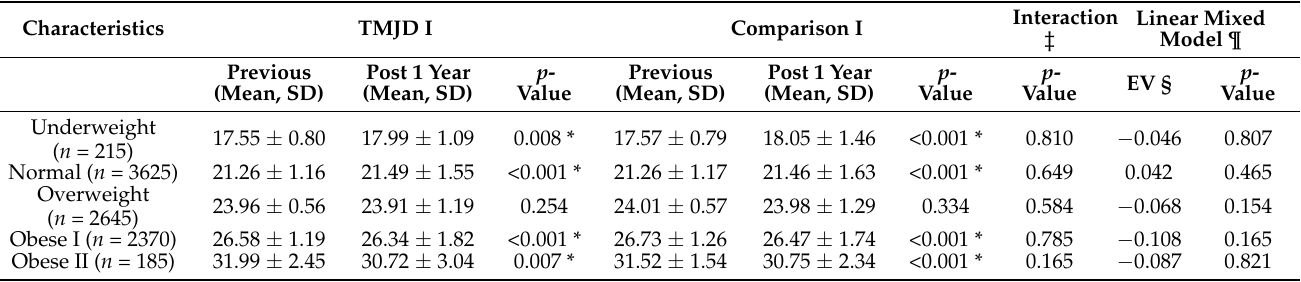
Table 3. Differences in mean BMI between pre- and 1-year-post-study of TMJD in TMJD I and the comparison I group according to obesity.